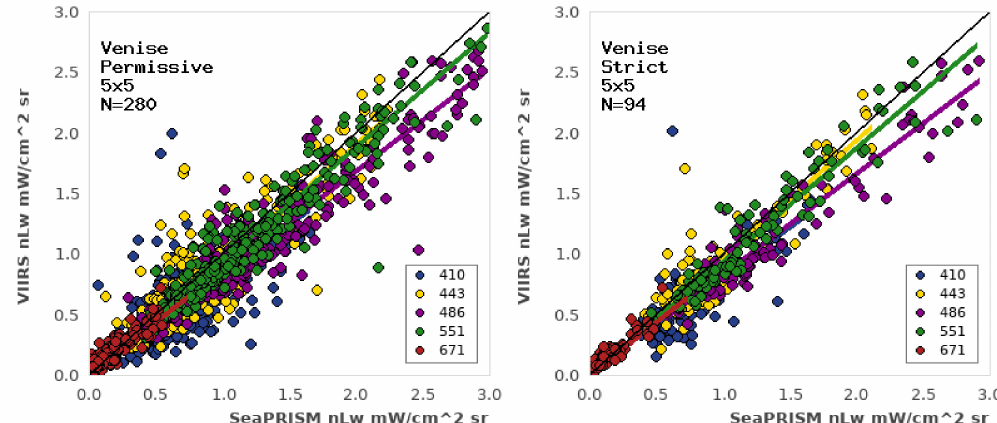
Figure 8. Venise–VIIRS comparison, June 2014 − May 2019, 5 × 5 statistical box comparison. Left: permissive; right: strict. There is a 67% drop once again in available match-ups. Table 7. Venise 5 × 5 permissive versus 5 × 5 strict. June 2014–May 2019. Values closest to one in bold, for slope, R 2 , and mean ratio. Lowest values in bold for bias and mean absolute error. Mean Protocol/Wavelength Match-Ups Slope R 2